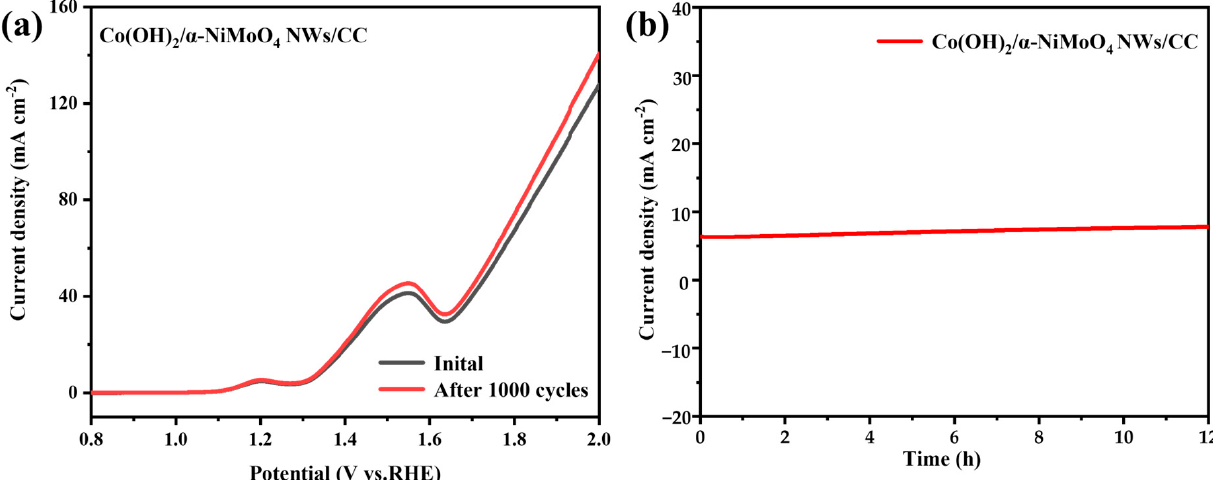
Figure 8. ( a ) Polarization curves LSV of Co(OH) 2 / α‐ NiMoO 4 NWs/CC electrocatalysts after 1000 cycles of CV; ( b ) stability of Co(OH) 2 / α‐ NiMoO 4 NWs/CC electrocatalysts at +1.23 V vs. RHE. As the OER and HER results indicate the good performance of Co(OH) 2 / α -NiMoO 4 NWs/CC, we further compared them with various other Co-, Ni-, and Mo-based elec- trocatalysts in 1 M KOH at the current density of 10 mA/cm 2 . As shown in Table 1, the as-prepared Co(OH) 2 / α -NiMoO 4 NWs/CC electrode shows better OER performance than most other Co-, Ni-, and Mo-based electrocatalysts. Table 1. Comparison of the OER and HER performances of Co(OH) 2 / α -NiMoO 4 NWs/CC with other Co-, Ni-, Mo-based electrocatalysts in 1 M KOH at a current density of 10 mA/cm 2 . OER Overpotential HER Overpotential Composites. (mV vs. RHE) (mV vs.